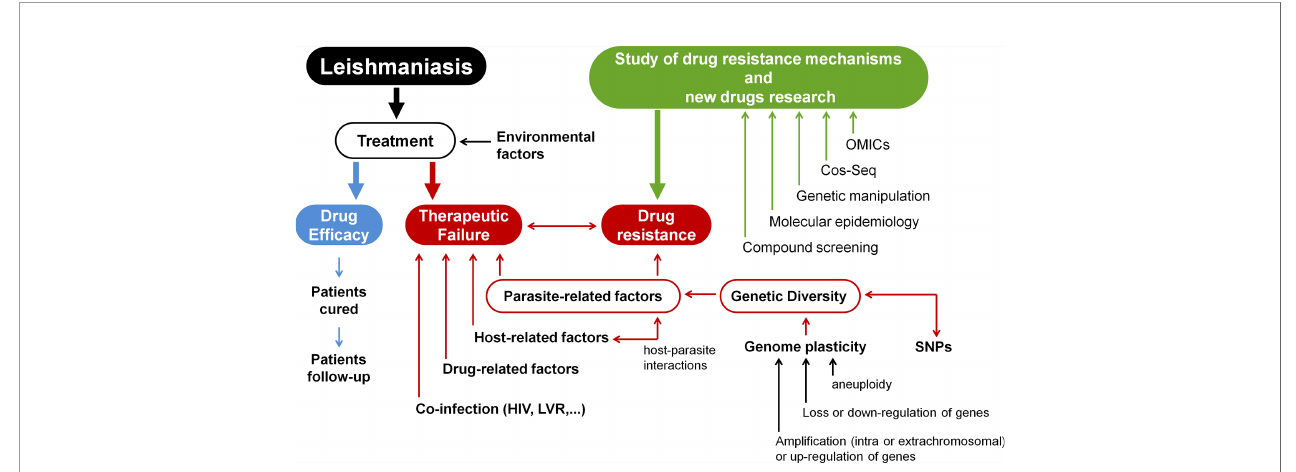
FIGURE 1 | Research into resistance mechanisms and the development of new drugs for leishmaniases treatment. Environmental variables, parasite-related factors, host-related factors, drug-related factors, and co-infections (HIV, LVR) can all affect how well a patient responds to therapy. This demonstrates the signi fi cance of studying host- Leishmania interactions in the context of developing novel chemotherapeutic agents for leishmaniasis. The parasite ’ s diversity is another key element in treatment outcomes since diversity is closely related to drug resistance. Because Leishmania ’ s genome is highly plastic, there is a great deal of variety across samples. Different Leishmania isolates display single-nucleotide polymorphisms (SNPs), as well as structural variations (such as changes in the numbers of genes, clusters of genes, or even whole chromosomes). Thus, genome plasticity involves different molecular modi fi cations, such as ampli fi cation or up-regulation of genes, loss or down-regulation of genes, or aneuploidy. These modi fi cations contribute to drug-resistant phenotypes in Leishmania samples. Consequently, drug resistance mechanisms are multifactorial and exceedingly complicated. Different approaches can be used to study resistance mechanisms in Leishmania and also to search for new molecular targets and novel drugs. OMICs integration (such as genomics, transcriptomics, proteomics, and metabolomics) can be used to better understand pathways associated with drug metabolism. However, due to post-transcriptional control, genomic and transcriptomic data should be interpreted with caution. In addition, data from promastigotes should be carefully analysed since such amastigote forms have distinct transcriptomic and proteomic pro fi les. The high-throughput Cos-Seq method can be used to identify gain-of-function resistance mechanisms and drug targets. Genetic manipulation of parasites can be performed using different molecular tools (such as deletion by allelic substitution, overexpression and heterologous expression, plasmid shuf fl ing, RNAi, DiCRE, DD domain, Cos-Seq method, and CRISPR/Cas9) which allow the identi fi cation of novel chemotherapeutic targets. Molecular epidemiology is also important to better understand the diversity of the genus Leishmania and the variables that drive diversi fi cation. Finally, compound screening is a critical component in the search for novel drugs (Modi fi ed from Ponte-Sucre et al.,